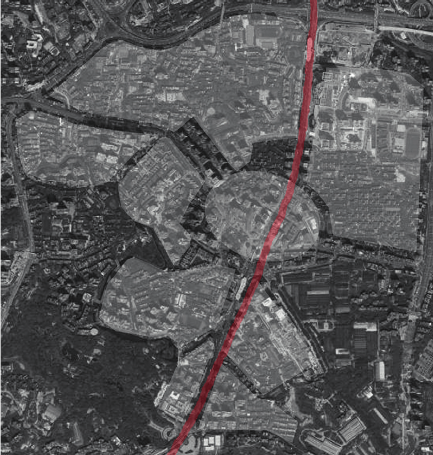
Figure 1: Location of the study area and the distribution of res- idential